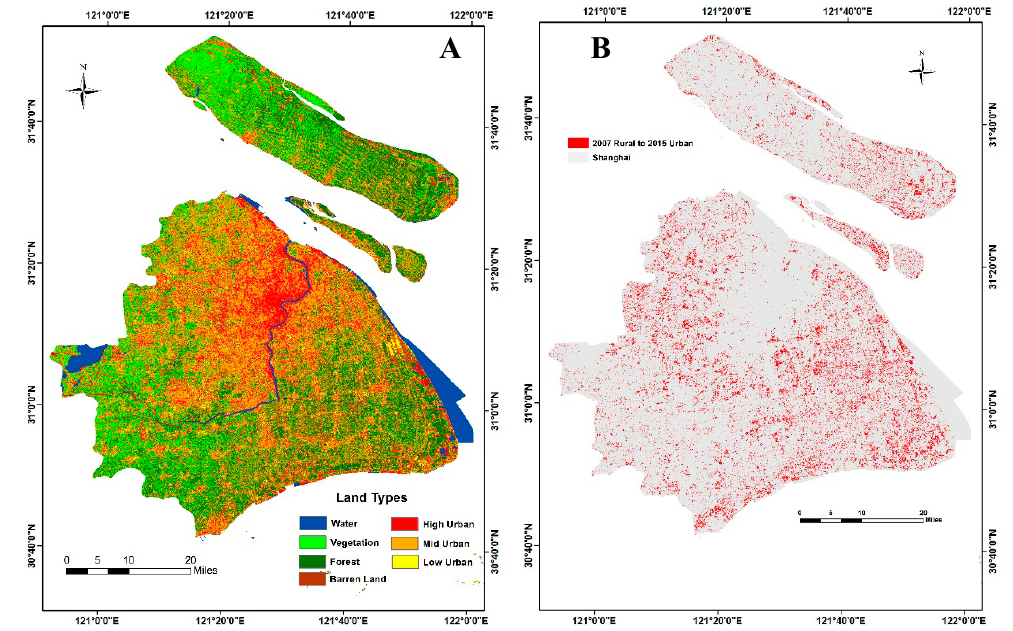
Figure 2. ( A ) Classification results of Shanghai (2007). ( B ) Urban expansion in Shanghai between 2007 and 2015.